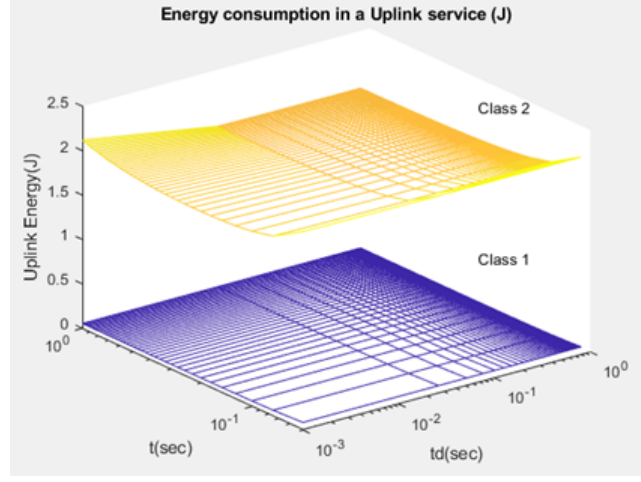
Figure 17. Energy of uplink service request— ξ uj .